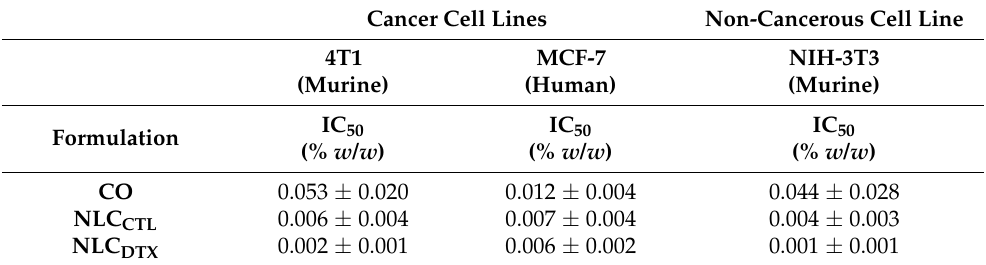
Table 3. IC 50 values determined for CO against 4T1, MCF-7, and NIH-3T3 cells, after 24 h of treatment and measured by the MTT assay. Analysis made with the GraphPad Prisma 8 software of the values taken from the curves in Figure 7. Cancer Cell Lines Non-Cancerous Cell Line 4T1